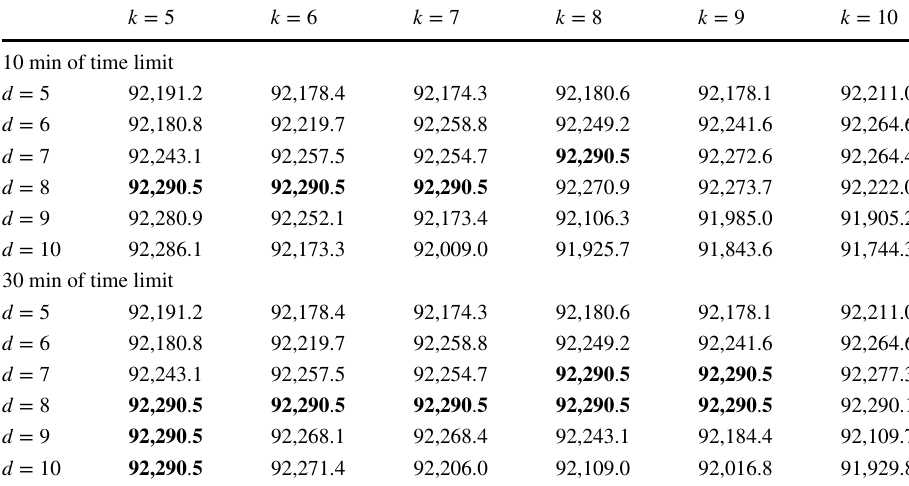
Table 1 Comparison of VDLS with different settings of parameters with 10 or 30 min of time limit in solving the 30 instances of the first set